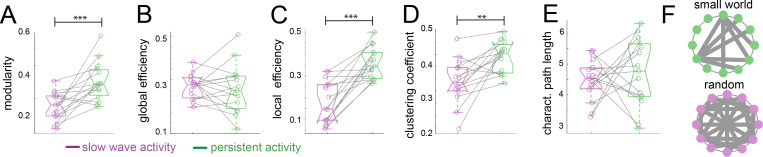
Graph theory shows a random network signature during slow wave activity.Legend: *=p < 0.05; **=p < 0.01; ***=p < 0.001 (paired t-test n = 15); slow wave activity (magenta), persistent activity (green). vertical dashed line represents the data distribution, central horizontal bar the median and the two extremes horizontal bars point the interquartile range. (A) Modularity values. (B) Global efficiency values. (C) Local efficiency values. (D) Clustering coefficients. (E) Characteristic path lengths. (F) Diagram representing a characteristic configuration of small world (green) and randomized networks (magenta).